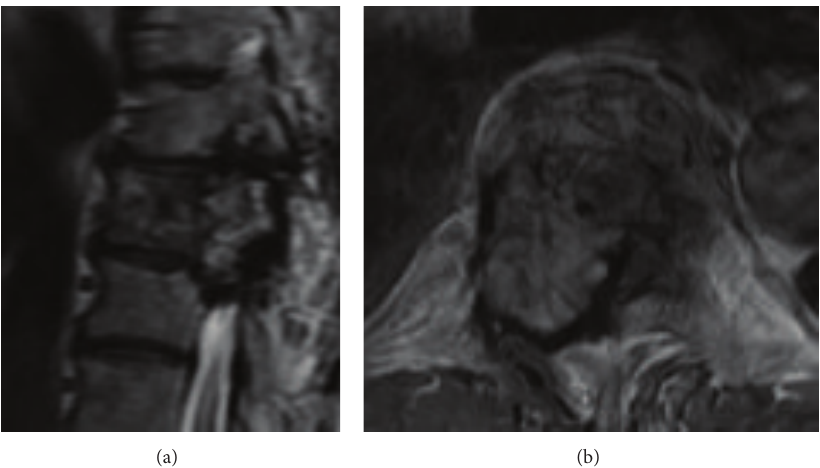
Figure 2: Preoperative MRI showing a multilevel invasive vertebral tumor with extraosseous extension. (a) Sagittal T2-WI, (b) axial gadolinium-DTPA-enhanced T1-WI image (T9).